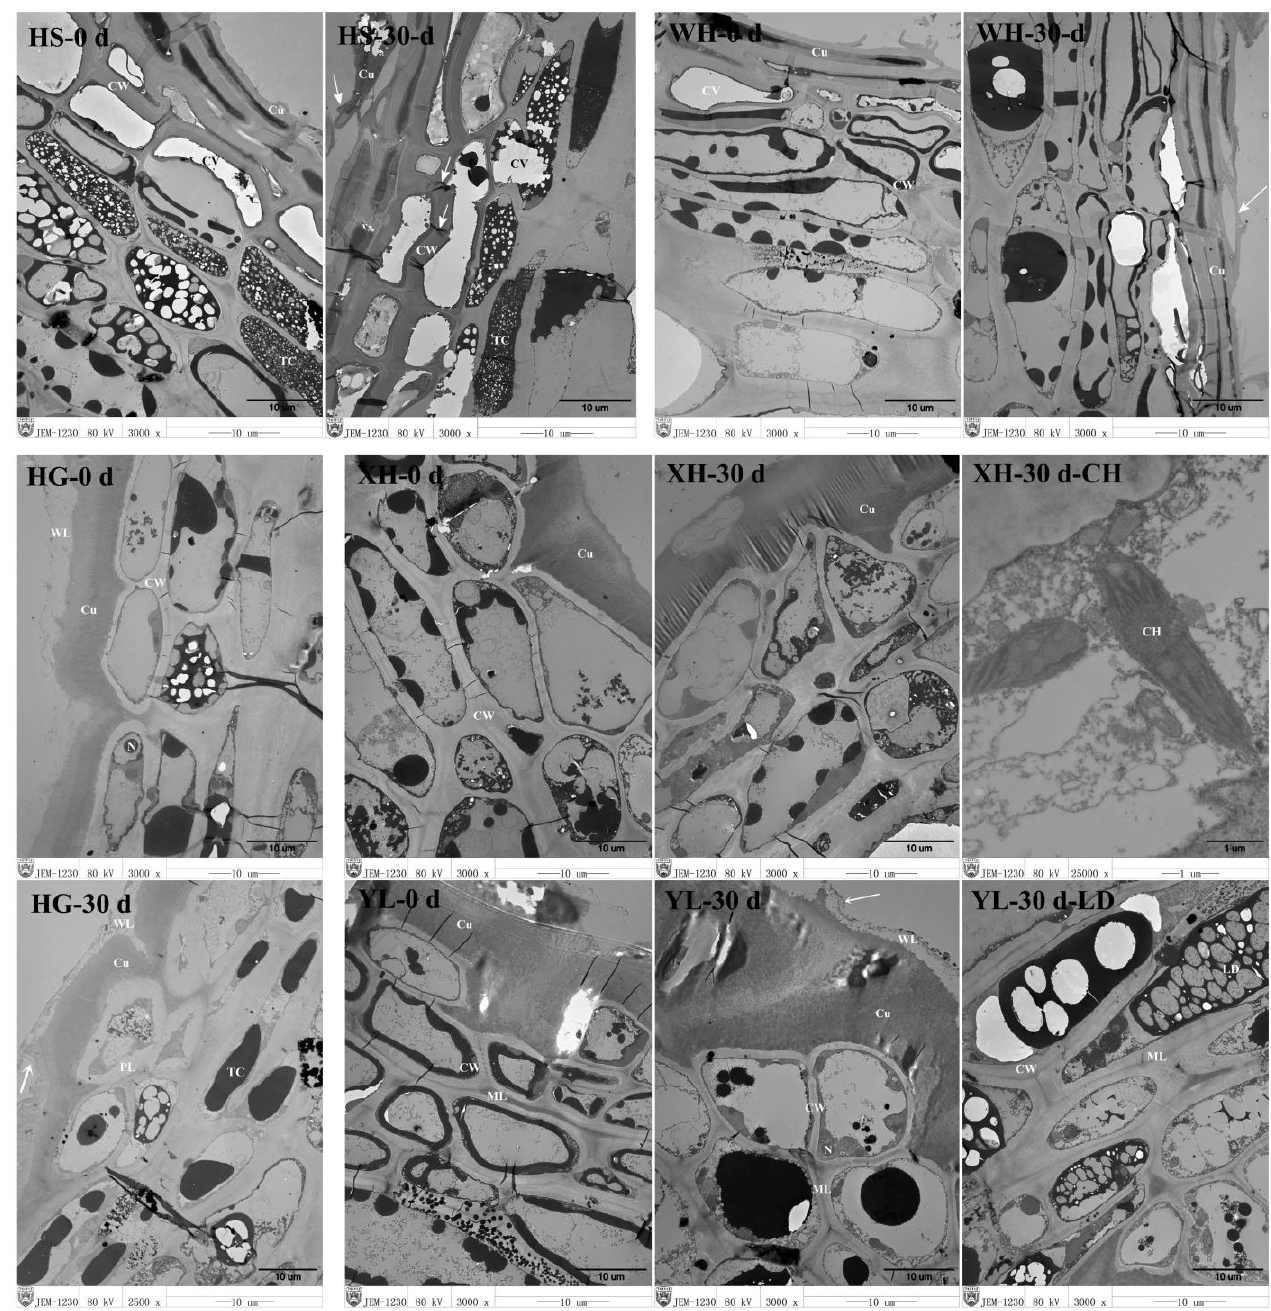
Figure 2. Observations of the pear peel structure using the transmission electron microscope. Cu: cuticle; CW: cell wall; CV: hollow cells; WL: wax layer; N: cell nucleus; TC: tannin cells; PL: separation of cytoplasm and wall; CH: chloroplast; ML: middle lamella; LD: lipid droplet.